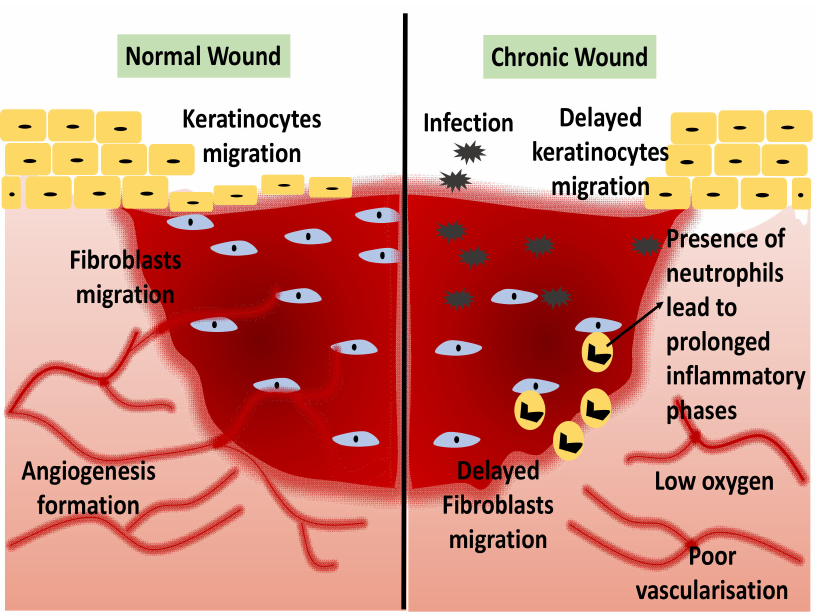
Figure 2. A comparison between normal and chronic